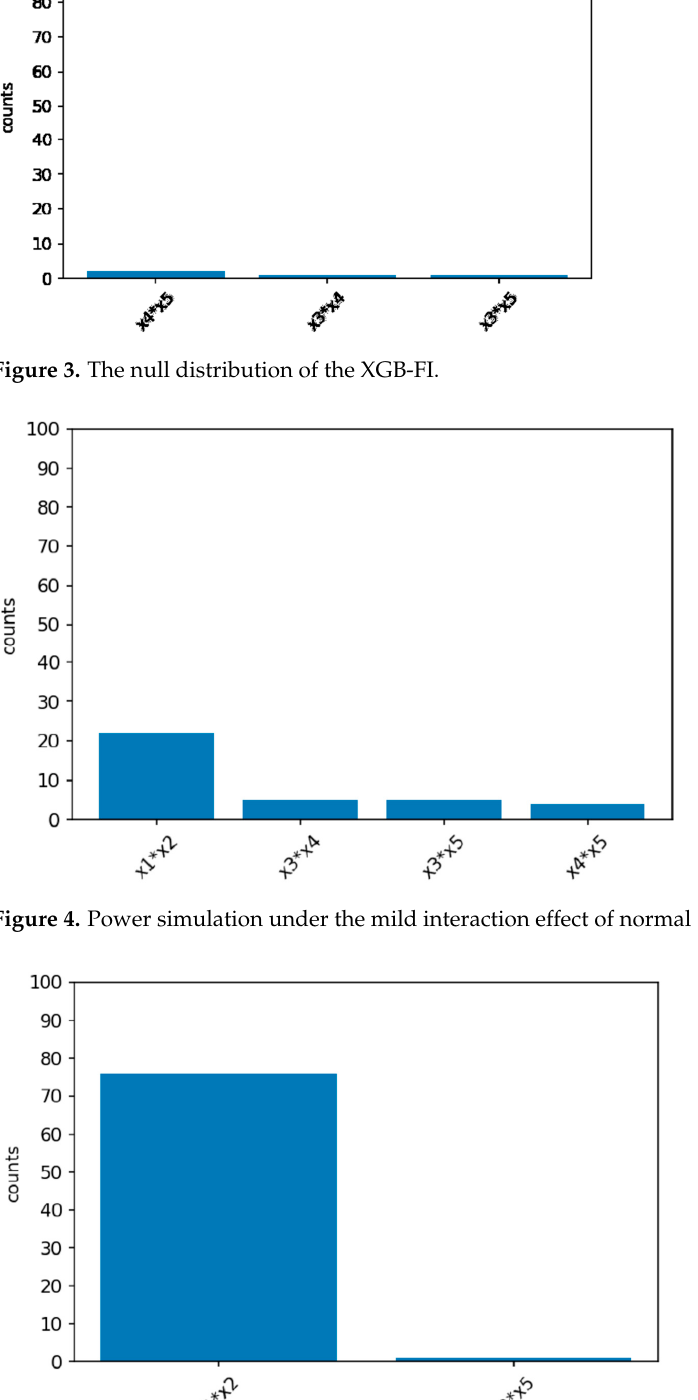
Figure 3. The null distribution of the XGB-FI.